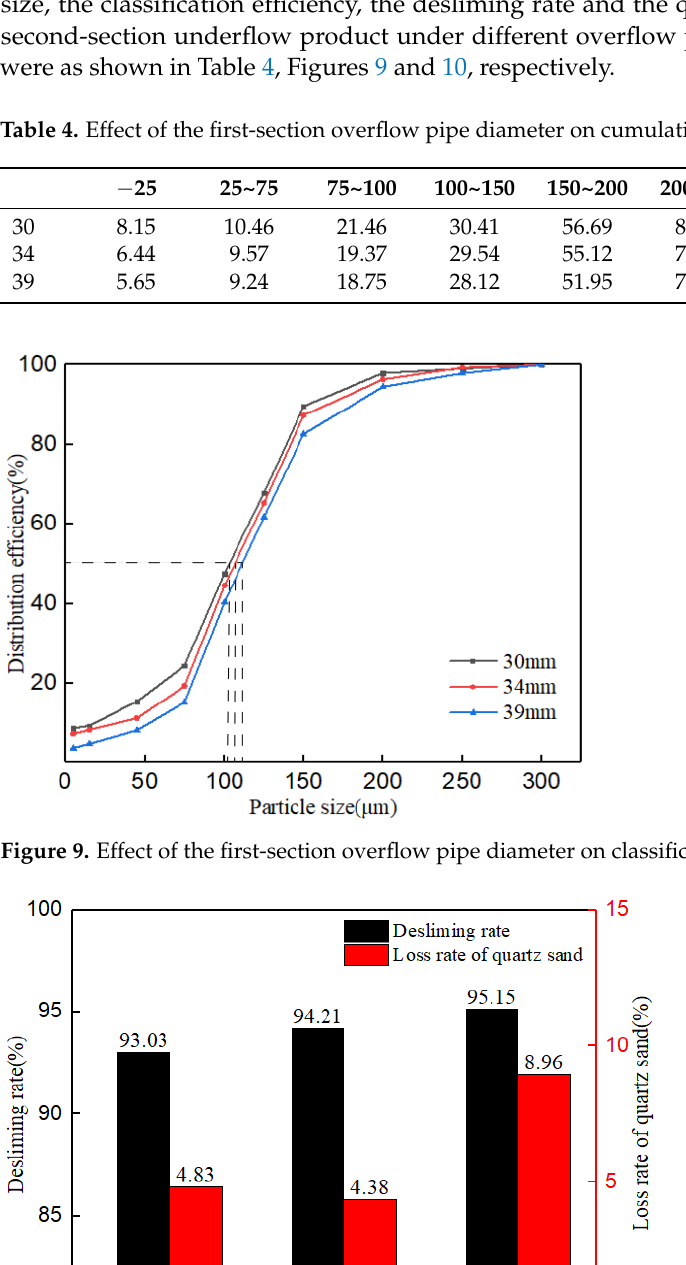
Table 4. Effect of the first-section overflow pipe diameter on cumulative particle size content.